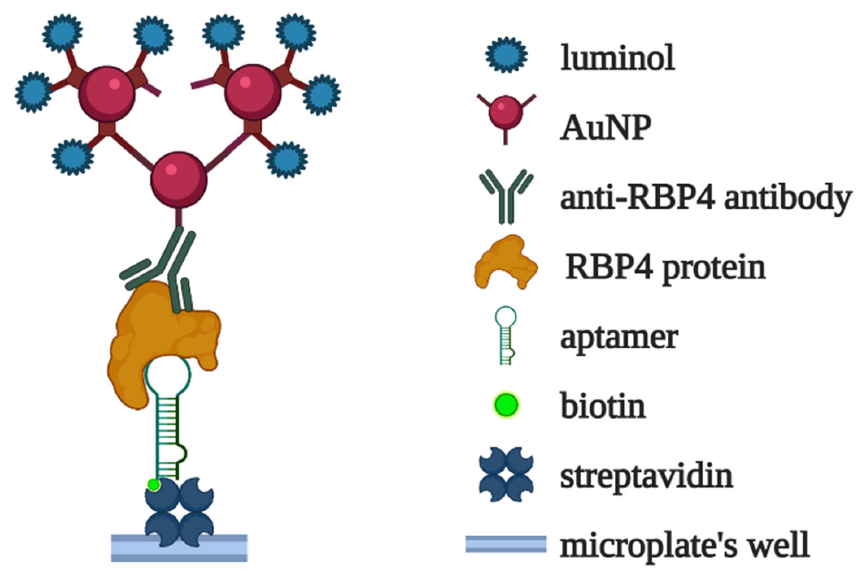
Figure 11. Chemiluminescent detection of RBP4 proposed in [61]. RBP4-specific aptamer captures the analyte in the microplate well. The aptamer–RBP4 complexes are visualized via conjugates of anti-RBP4 antibodies with covalently crosslinked luminol-modified AuNPs. A pair of DNA aptamers recognizing the different epitopes of vaspin were used for detection in lateral flow assay [62]. The first aptamer—conjugated with AuNPs—served as a reporter probe, while the second aptamer—immobilized on a test line—captured vaspin from the solution (Figure 12). Without vaspin, the AuNP–aptamer conjugate binds with complementary DNA at the control line, forming a red color. In the presence of the analyte, the vaspin-bound AuNP–aptamer conjugate passes the control line and stops in the test zone, where vaspin binds to the second aptamer. The limit of detection for the proposed LFA was about 0.1 nM, both in the model buffer solution and serum samples.